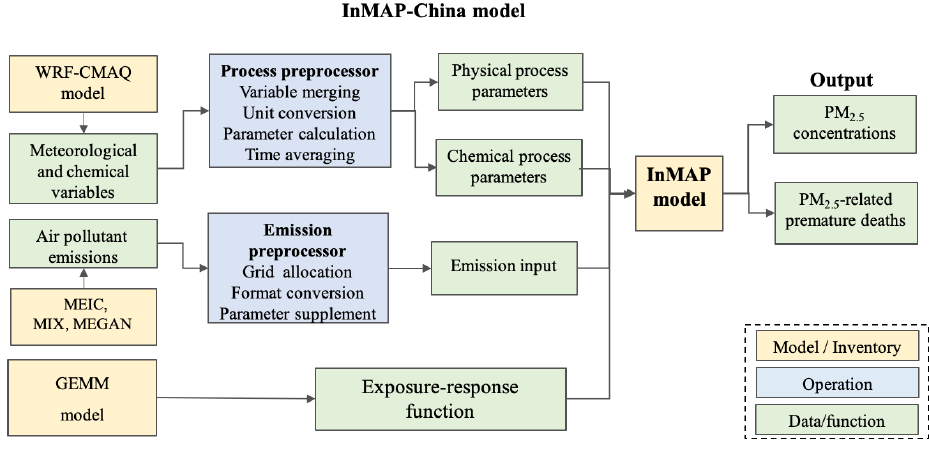
Figure 1. Model framework of InMAP-China. Table 1. Model configurations in